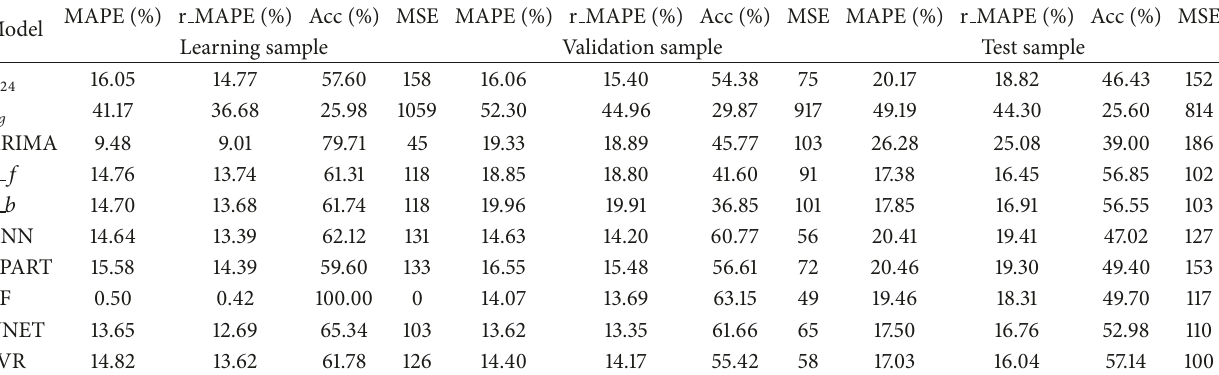
Table 6: Forecasting results for aggregate models of the entire